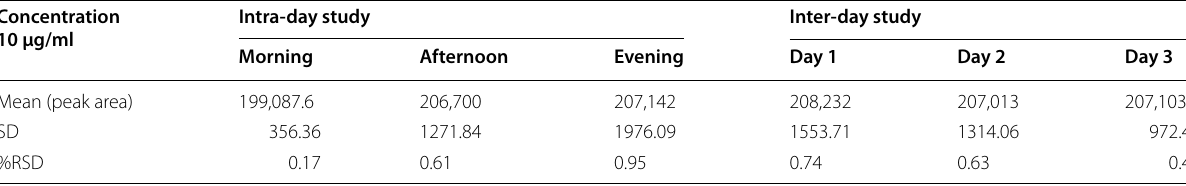
Table 4 Precision data of the RP-HPLC method for empagliflozin Concentration 10 µg/ml